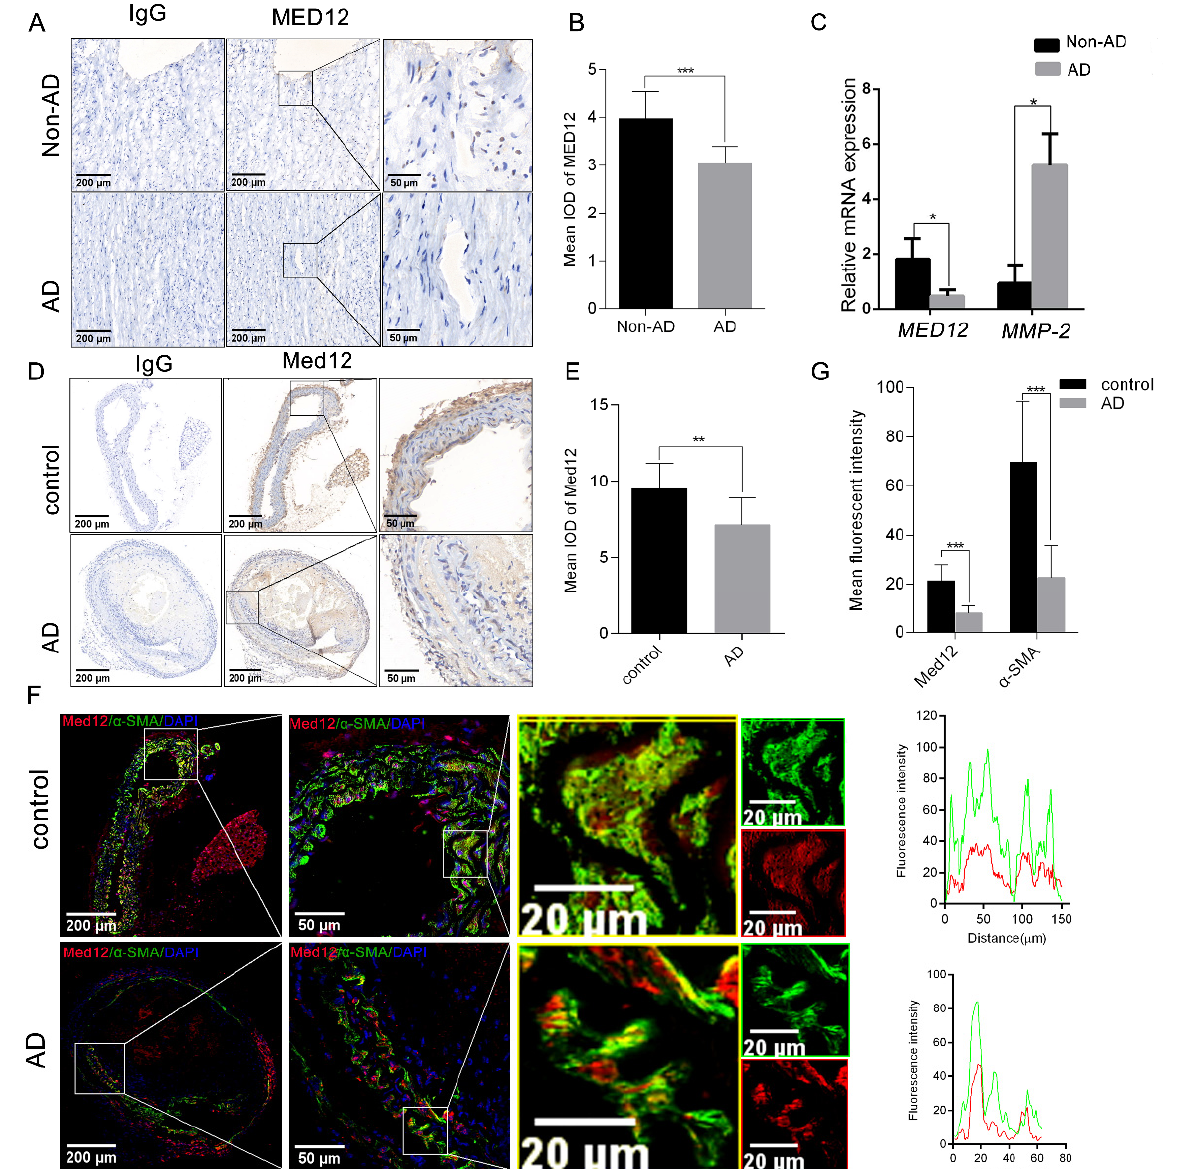
Figure 1. The expression of MED12 in aortic tissue. ( A ) Representative images of immunohistochemical staining in aortic sections from non-AD and AD patients. IgG as a negative control. ( B ) Quantitative analysis of MED12. ( C ) The mRNA expressions of MED12 in aortae of non-AD and AD patients were detected by RT-PCR, with MMP-2 as a positive control. ( D ) Representative images of immunohistochemical staining in aortae of AD and control mice. IgG as a negative control. ( E ) Quantitative analysis of Med12. ( F ) Representative images of immunofluorescent staining of Med12 in aortic sections from AD and control mice. Fluorescence intensities of MED12 (red) and α -SMA (green, smooth muscle cell marker) were analyzed. Right insets represent high-magnification images of each individual imaging channel and a merged image of the region (left). Pearson’s correlation coefficient (PCC) was employed to quantify colocalization. ( G ) Quantitative analysis of MED12 and α -SMA fluorescence intensity. Data are expressed as the mean ± SD. Statistical analyses, unpaired t -test. * p < 0.05; ** p < 0.01; *** p < 0.001.